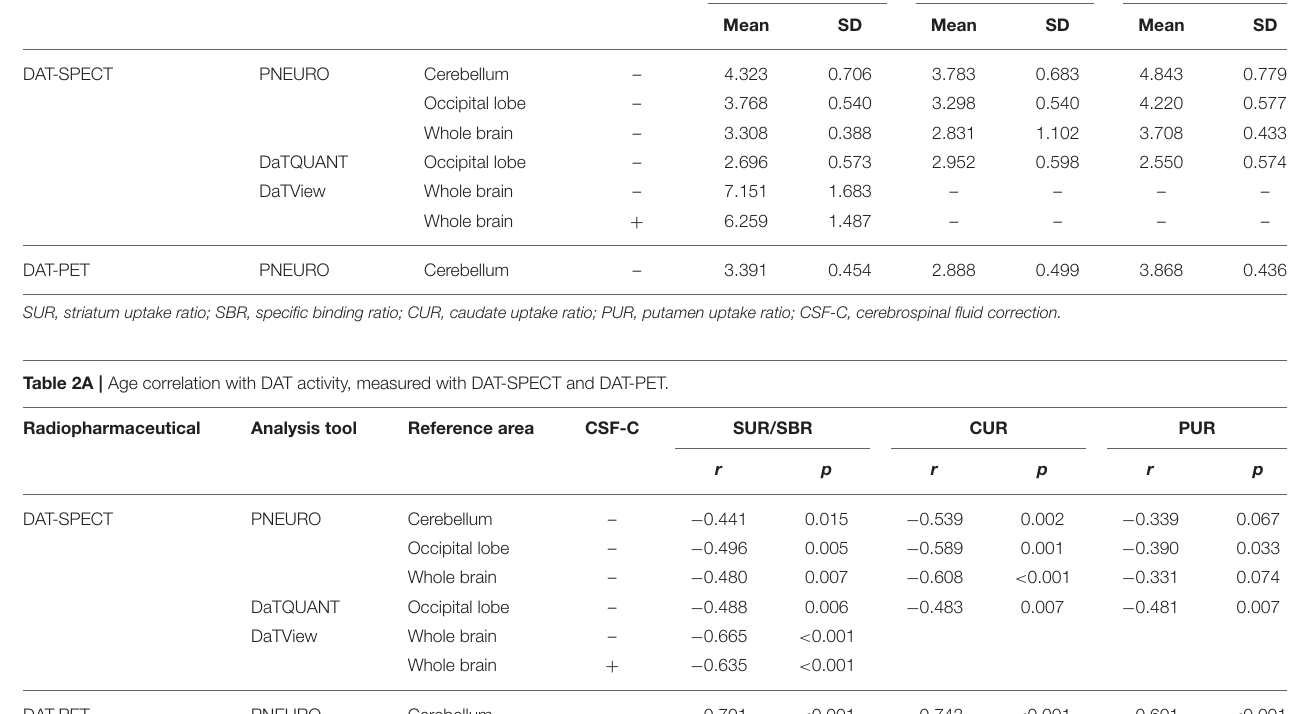
TABLE 1 | The SUR/SBR, CUR, and PUR of DAT-SPECT and DAT-PET. Radiopharmaceutical